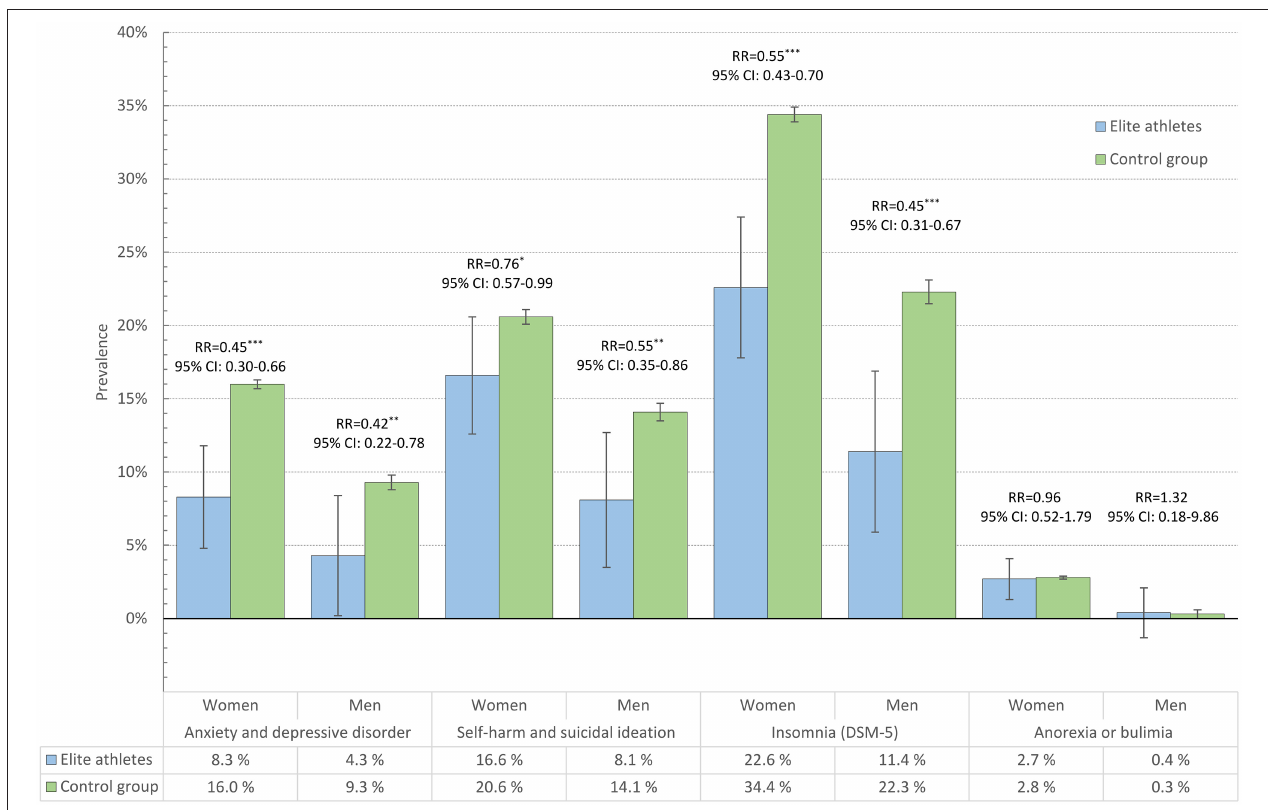
FIGURE 2 | Prevalence of anxiety and depressive disorders, self-harm and suicidal ideation, insomnia and eating disorders among elite athletes and control group, in male and female college and university students. Bars represent age-adjusted prevalence estimates, and error bars represent 95% confidence intervals. RR = age-adjusted relative risk. *** p < 0.001; ** p < 0.01; * p <